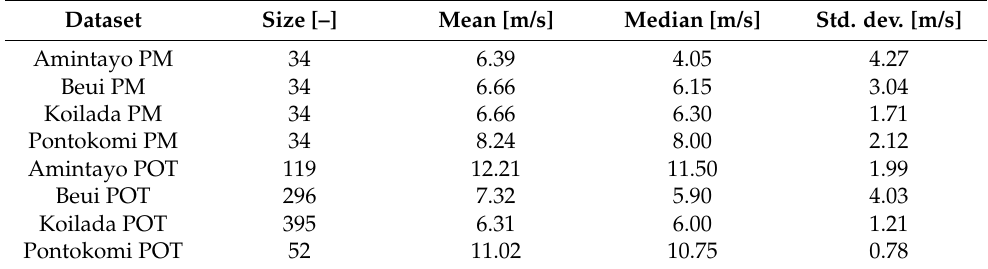
Table 2. Size and statistical characteristics of the datasets used in the experiments.